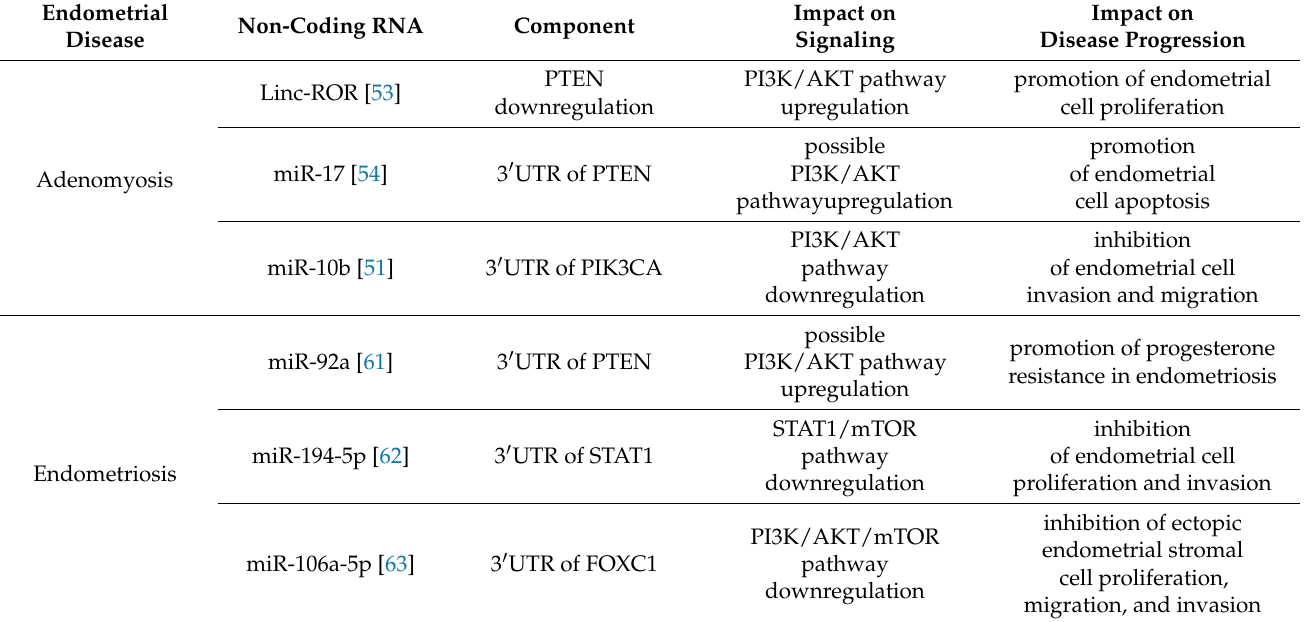
Table 1. Overview of non-coding RNA molecules identified interacting with upstream regulators of the mTOR